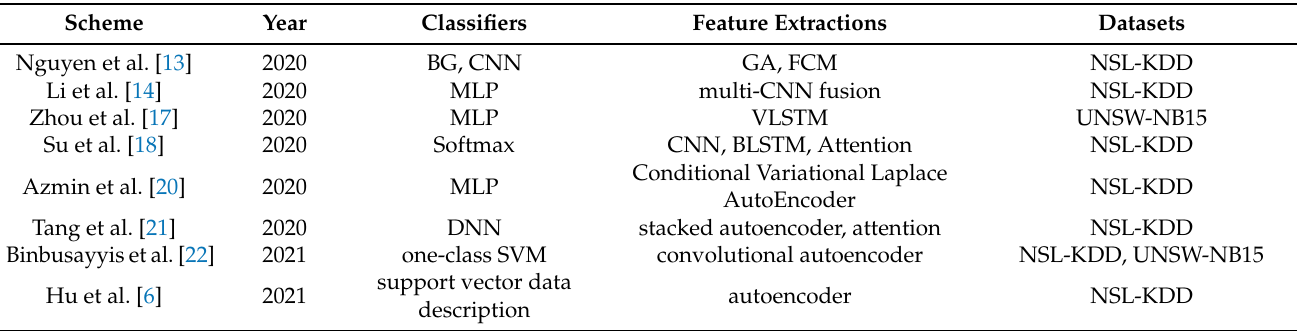
Table 1. Summary of reviewed papers in the